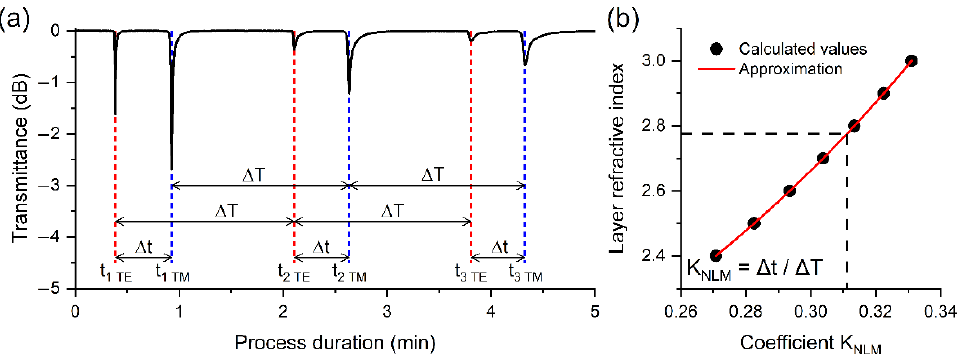
Figure 7. ( a ) Dependence of optical transmission at a wavelength of 1450 nm on the duration of the deposition process, the spectral response of which is shown in Figure 6c. ( b ) Dependence of the coating RI at a wavelength of 1450 nm on the coefficient K NLM .